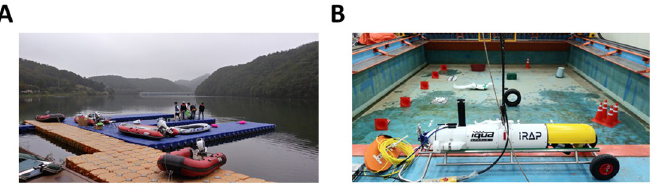
Fig 6. Underwater environments and platforms. (A) Reservoir and boat, (B) Pool and underwater vehicle.